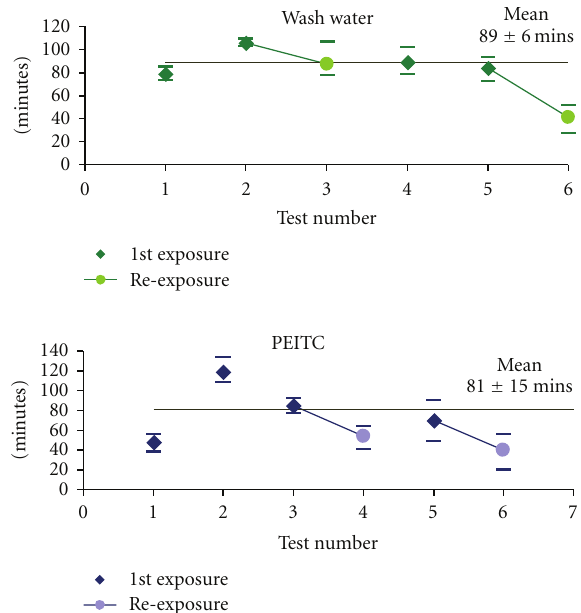
Figure 5: ET 50 (95% CI) values for exposures and re-exposures. The upper panel shows the ET 50 value for each PEITC exposure (green diamond) and re-exposure (green circle). The lower panel shows ET 50 value for each wash water exposure (blue diamond) and re-exposure (blue circle). Re-exposures are linked to the initial exposure by a solid line. Horizontal bars show the 95% upper and lower confidence intervals. Mean ET 50 ( ± SE) value for the initial exposures is shown as a solid black